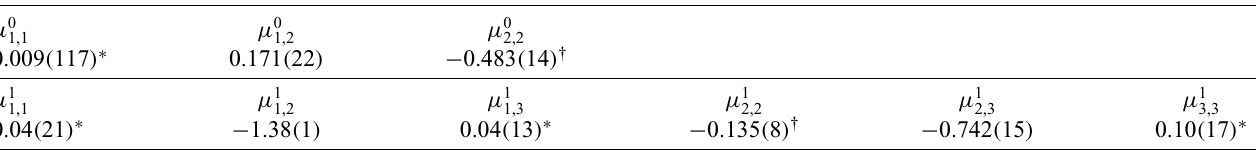
TABLE II. The μ J matrix elements for the two different symmetries corresponding to the fit in Fig 4. The superscript indicates the n , m total J value and the subscripts indicate channel